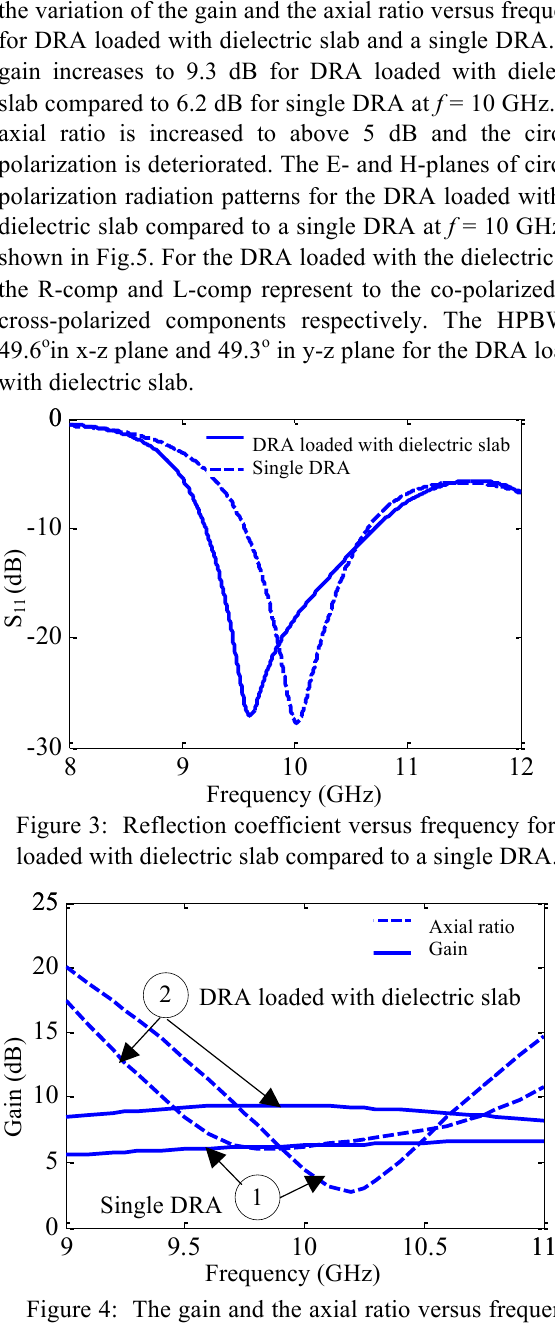
Figure 2: Geometry of a single DRA loaded with a dielectric slab placed at F above the ground plane. S